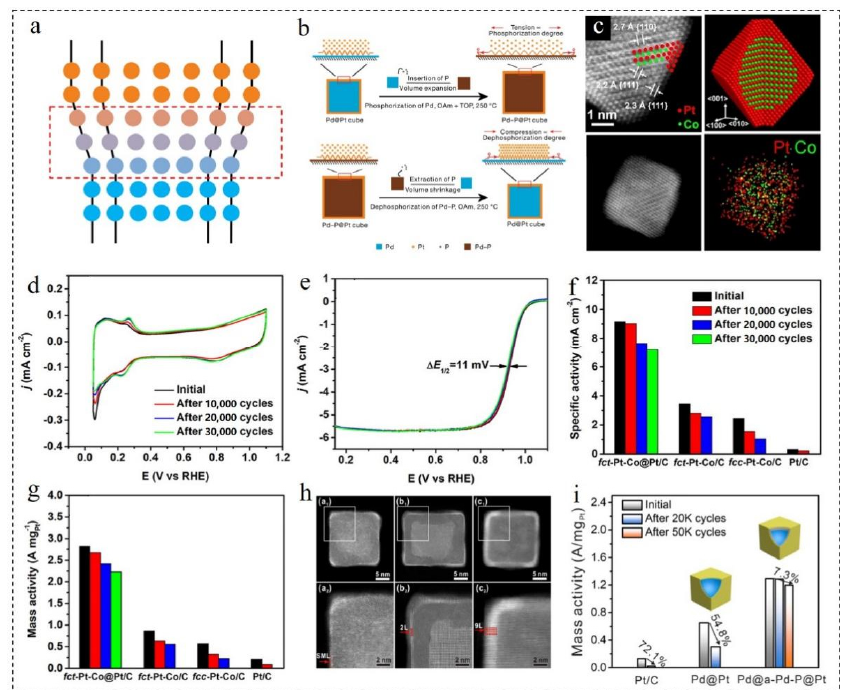
Figure 6. ( a ) Schematic of the strain field influenced by lattice mismatch at the interface. Reproduced with permission from [85]. Copyright © 2022, Nature. ( b ) A method for controlling lattice strain of ultrathin Pt shells. Reproduced with permission from [88]. Copyright © 2022, Nature. ( c ) Schematic, HAADF-STEM images and EDX mapping of PtCo@Pt NPs. ( d ) CV and ( e ) LSV curves recorded from the fct-PtCo@Pt/C NPs before and after different cycles. ( f ) Specific and ( g ) mass activity of the catalysts at 0.9 V (vs. RHE) before and after different cycles. Reproduced with permission from [89]. Copyright © 2022, American Chemical Society. ( h ) HAADF-STEM images and ( i ) ORR performances of Pd@a-Pd-P@Pt. Reproduced with permission from [95]. Copyright © 2022, American Chemical Society.